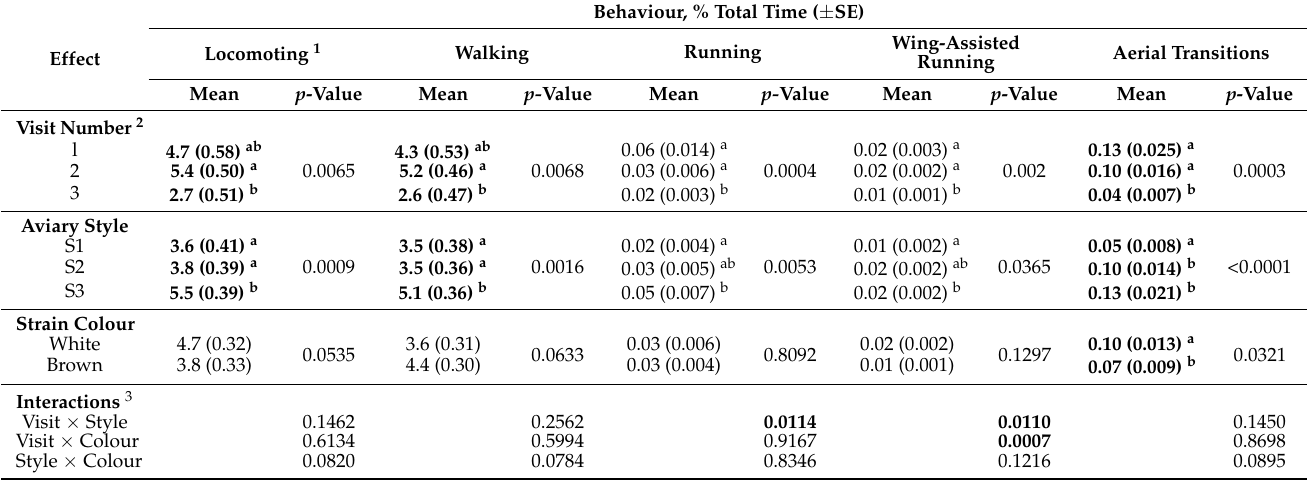
Table 3. Least square means ( ± standard error) of the percentage of total time brown- and white-feathered strains of layer pullets housed in three different styles of commercial rearing aviary systems of increasing structural complexity spent on locomotory behaviours throughout the rearing